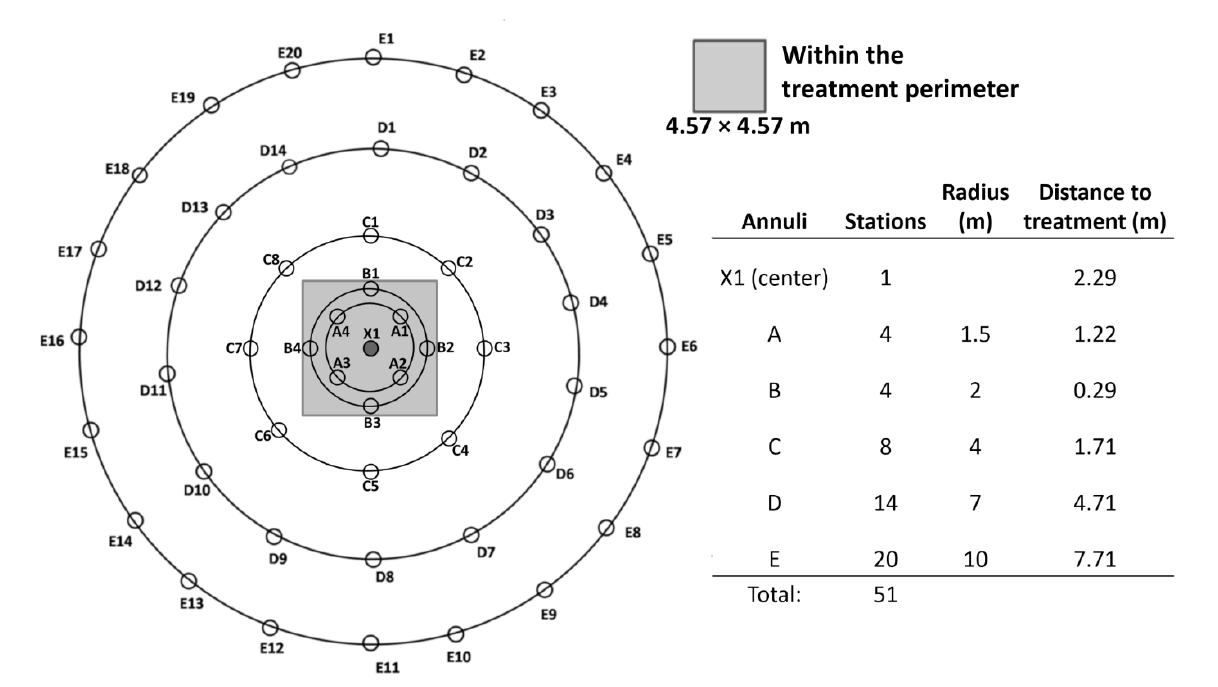
Fig 1 . Diagram of experimental grids indicating the location of termite stations, grid sections, and the treatment perimeter. Distances to treatment are minimum horizontal or vertical distances to a side of the treatment perimeter. Exact distances to treated soil vary from station to station and may be